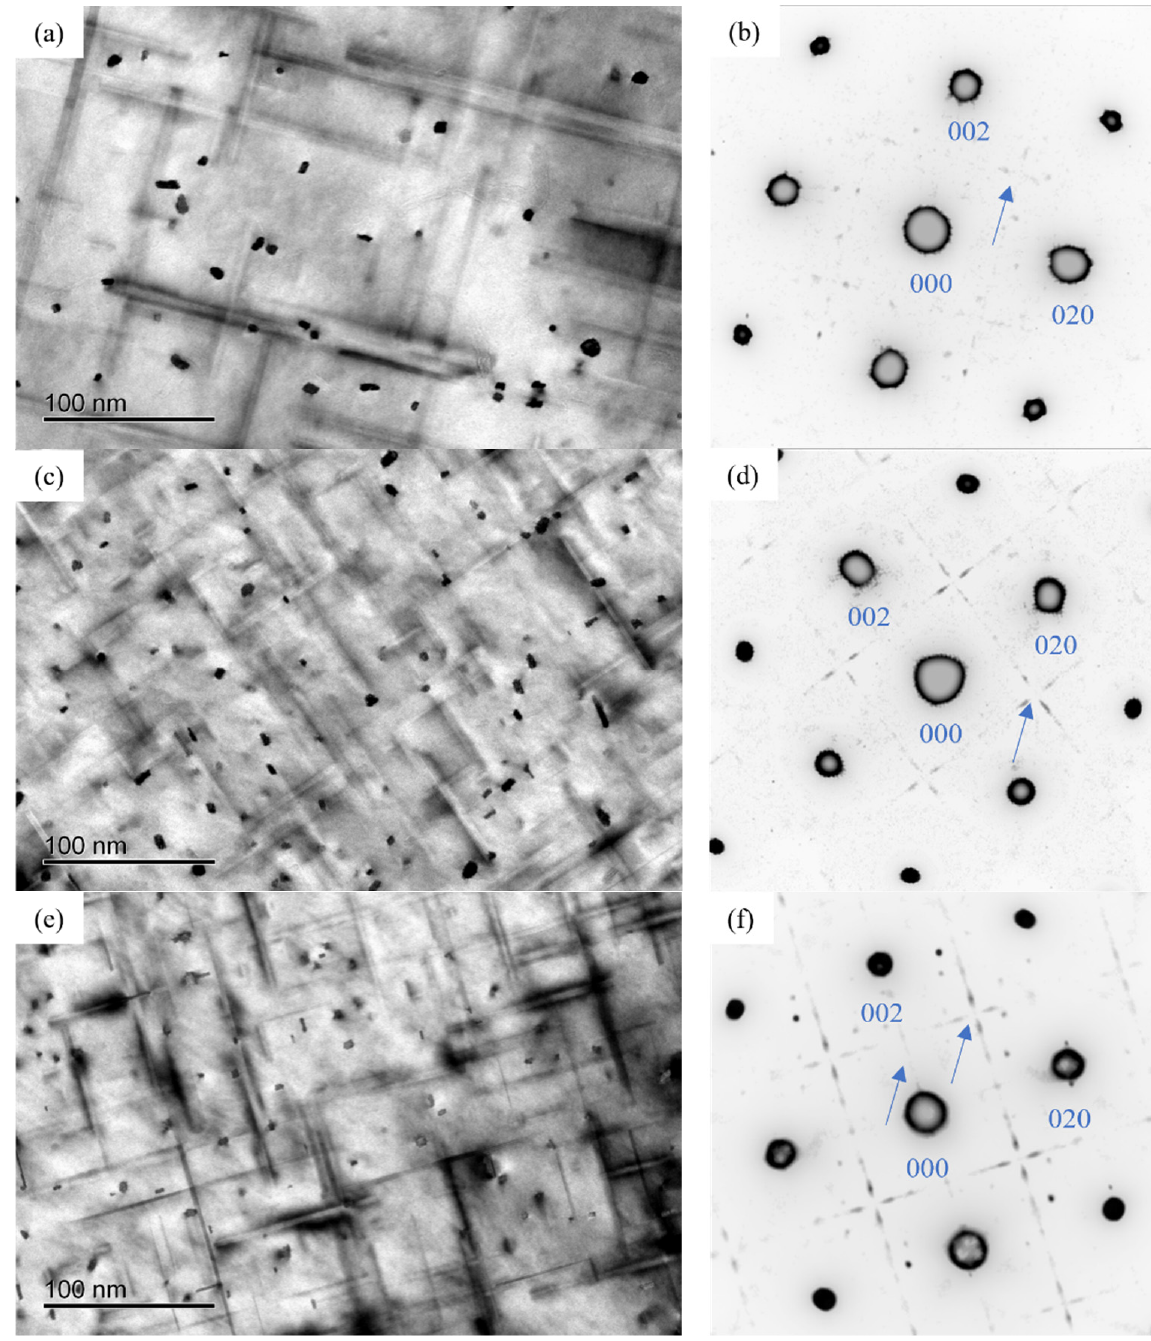
Figure 12. BF image and SAED patterns after over-aging at 175 ◦ C for 72 h of three alloys. ( a , b ) 0Cu alloy; ( c , d ) 0.18Cu alloy; ( e , f ) 0.37Cu alloy. Figure 13 revealed the HRTEM and FFT of the precipitates of 0Cu alloy after over- aging at 175 ◦ C for 72 h. By calibrating the lattice parameters of the precipitates, two